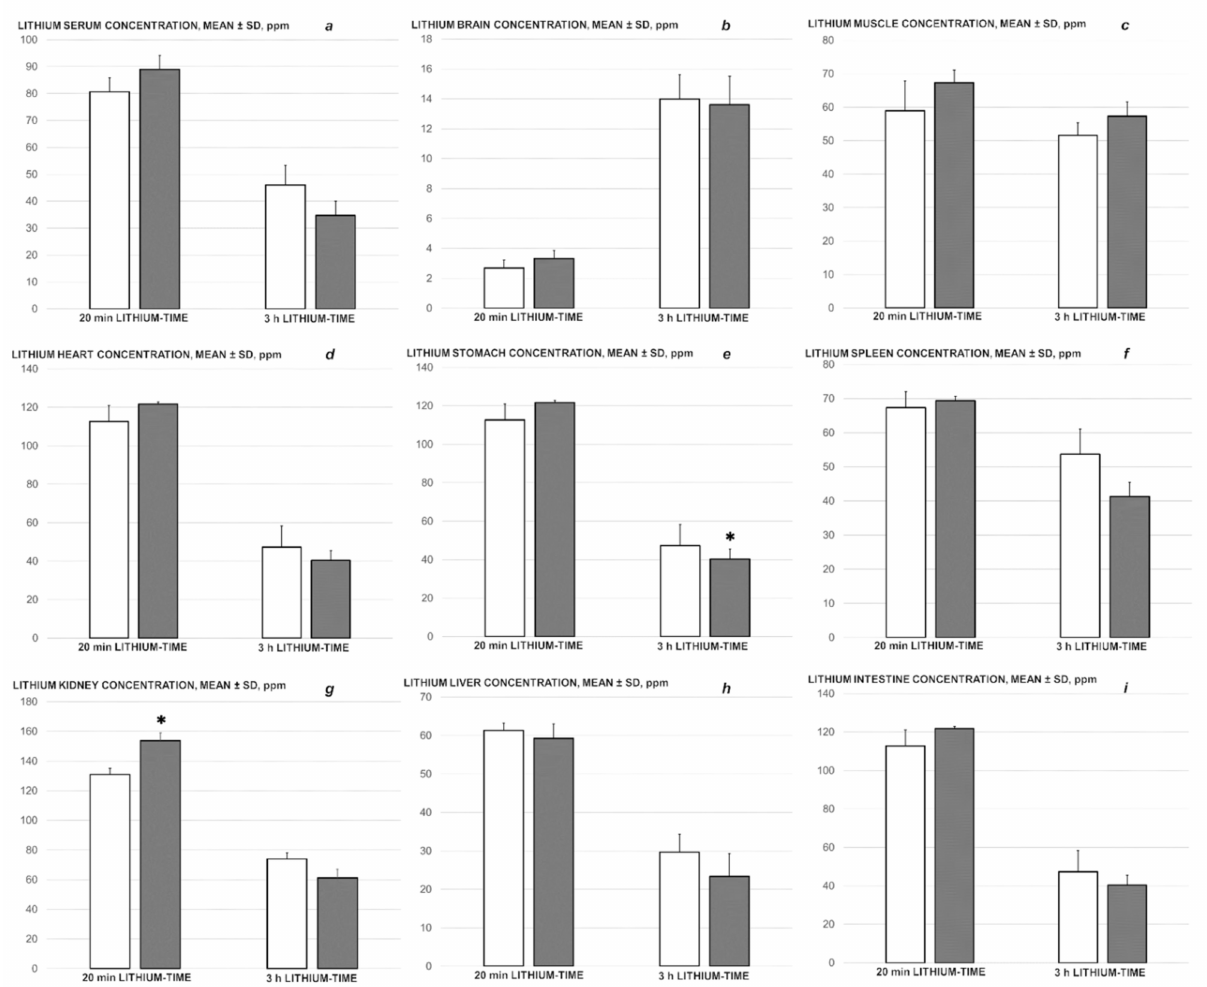
Figure 20. At 20 min or 3 h after administration of lithium sulfate (500 mg/kg ip) (lithium-time), followed by BPC 157 10 ng/kg ip (dark gray bars), or saline 5 mL/kg ip (white bars); concentrations of lithium were assessed in samples of rat serum ( a ), brain ( b ), muscle ( c ), heart ( d ), stomach ( e ), spleen ( f ), kidney ( g ), liver ( h ), and intestine ( i ). Means ± SD, * p < 0.05, at least vs.